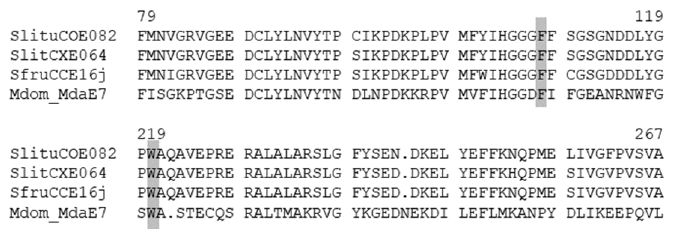
Figure 3. Alignment of two 50 amino acid sequence portions of SlituCOE082, SlitCXE64, SfruCCE16j and MdaE7 from Musca domestica (Rutgers diazinon-R resistant strain). The putative mutation positions G151D and W271L are shaded in grey. According to [67], the amino acid corresponding to G137D and W251L were G107 and W219 in S. litura sequence; for S. litura carboxyl/cholinesterase (CCE), the mutation tested in vitro was G151D. Genbank accession number, S. frugiperda (XP_035450257.1), S. litura (XP_022828113.1), M. domestica (AAD29685.1).